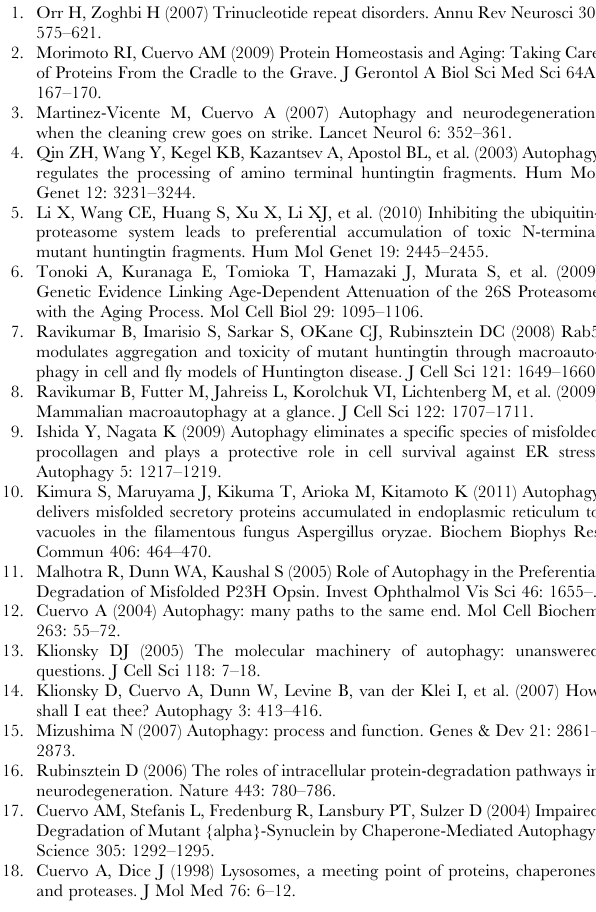
Figure S3 Association of Htt-552 and endogenous CMA component proteins. (A) Endogenous expressed LAMP-2A or Hsc70 co-localized with exogenous Htt-552-100Q in HeLa cells. Cells were transfected with Htt-552 for 48 h and fixed with methanol, blocked, and processed for double immunofluorescence with antibodies against Htt-552-100Q (red) Htt-552-100Q (red) and LAMP-2A (green) or Hsc70 (green). Merged images of